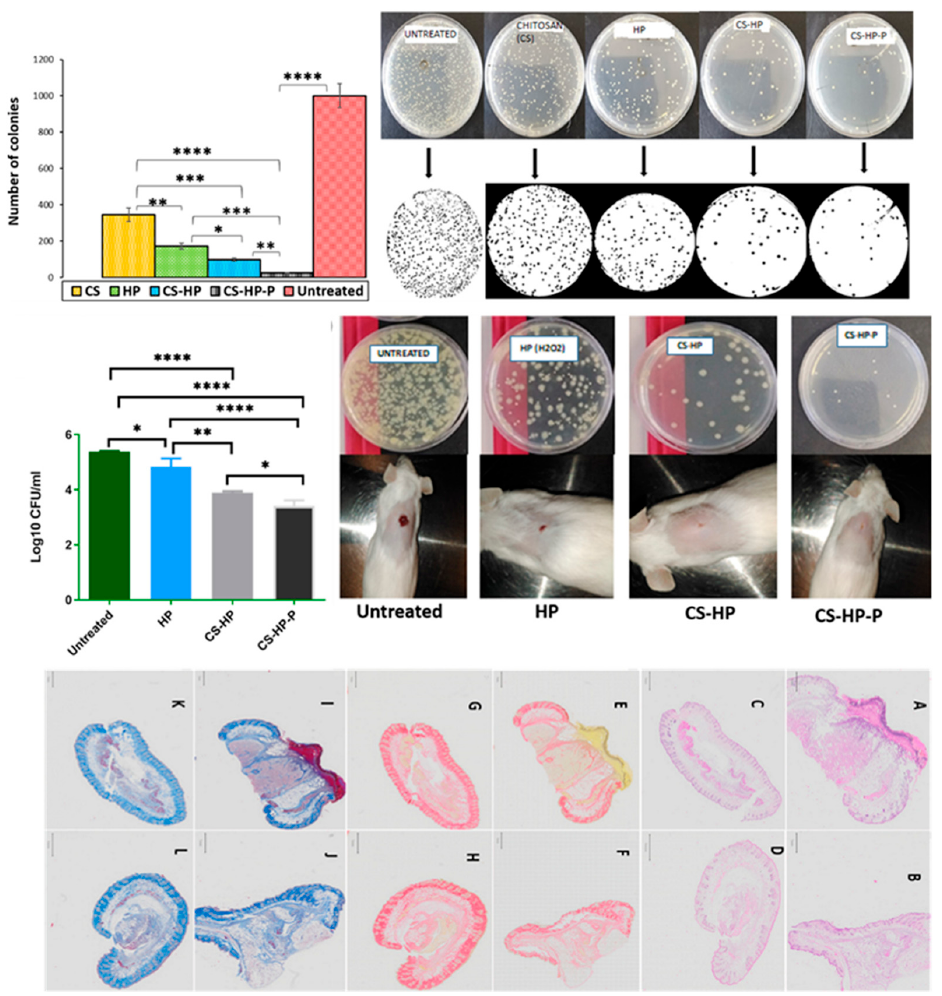
Figure 15. Number of colonies of untreated MRSA biofilms and biofilms exposed by chitosan-based hydrogels. Evaluation of MRSA burden post-treatment. Physical observation of the wound closure and bacterial burden. Photomicrographs of the untreated and treated skin sections stained with H&E, PSR, and CAB (0.5×), adopted from open access resource [39].